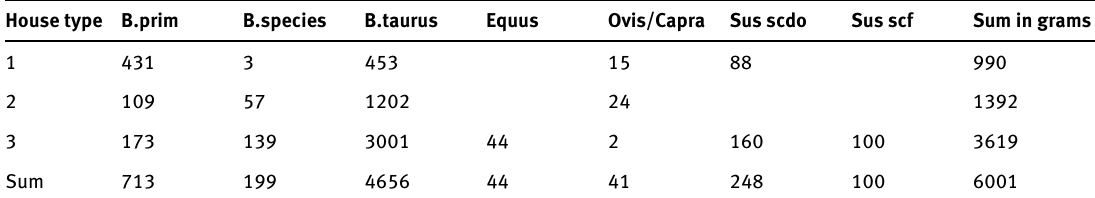
Table 2a: Bylany (distr. Kutná Hora), pottery phases 9 to 25. Amount of animal bones in house types. Data after Peške, Rulf, Slavíková (1998).